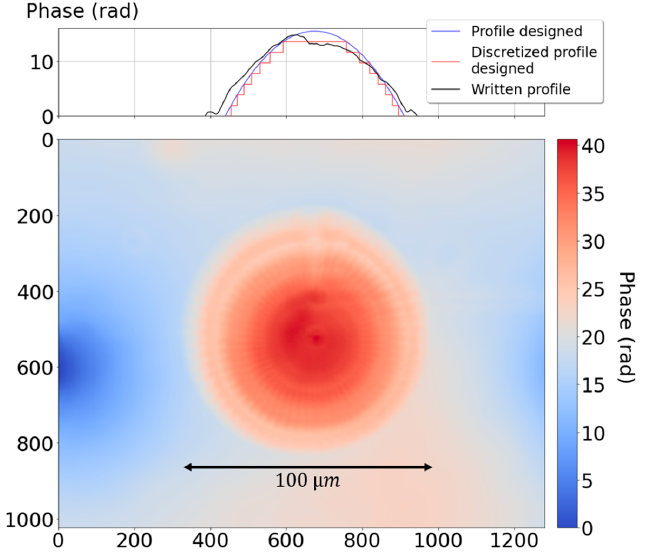
Figure 6. Quantitative phase map of a gradient index lens written in GeS 2 glass sample at 1 mm/s scanning speed. Top: plot of the designed profile and the imprinted profile after background subtraction. Laser parameters: 1030 nm, 800 fs, 100 kHz, 0.6 NA.